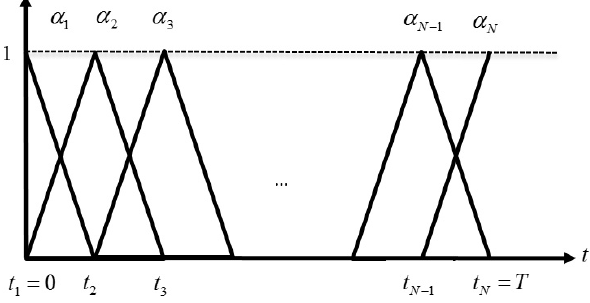
Figure 1. Finite element basis functions are in the form of an N hat function. Increasing N makes the algorithm more computationally expensive, but helps to find shorter